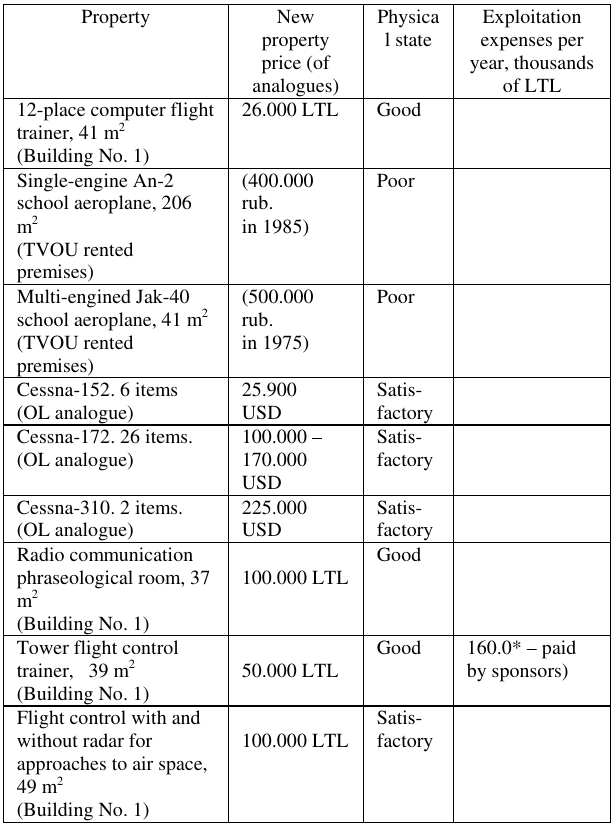
Table 2. Facilities used at VGTU Antanas Gustaitis